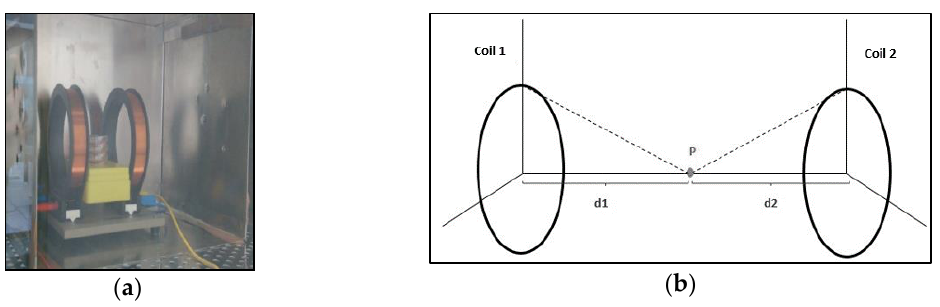
Figure 1. The extremely low frequencies-electromagnetic field (ELF-EMF) system: ( a ) a pair of Helmholtz coils inside a mu-metal box; ( b ) the scheme of a pair of Helmholtz coils, where P is the point placed in the center of the axis, d1 is the distance from Coil 1 to the point P, and d2 is the distance of the Coil 2 to the point P.